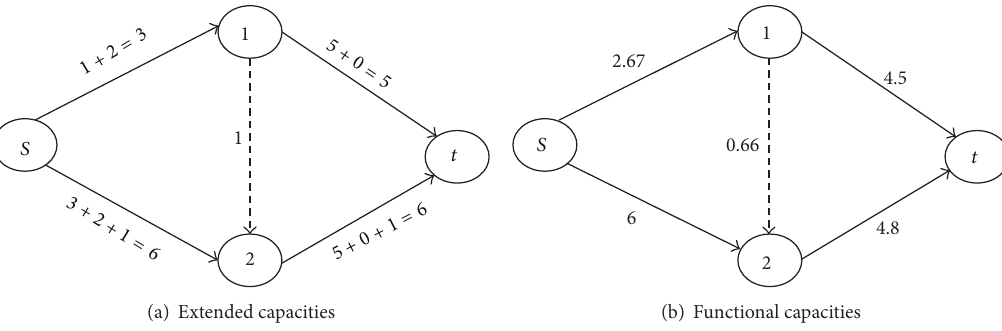
Figure 3: The result of running CEA using 𝐴 1 .